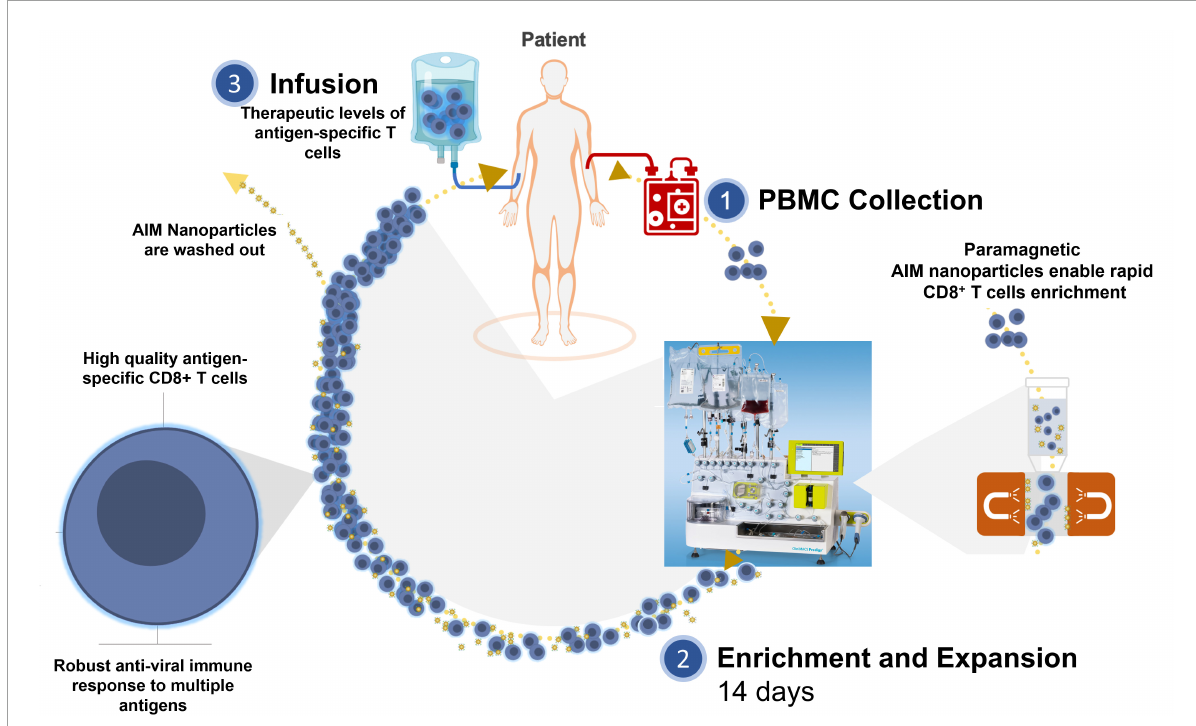
FIGURE1 Artificial Immune Modulation Adoptive Cell Therapy (AIM ACT). (1) Leukapheresis material is collected from a patient with infection ( e.g. , EBV, HTLV-1, HPV, and HIV). (2) The CD8 + T cells are enriched for using paramagnetic AIM nanoparticles that function as artificial APCs (aAPCs) to expand CD8 + T cells specific for immunodominant viral antigens. (3) After 14 days expansion, AIM nanoparticles are washed out and the AIM ACT is ready to be infused into